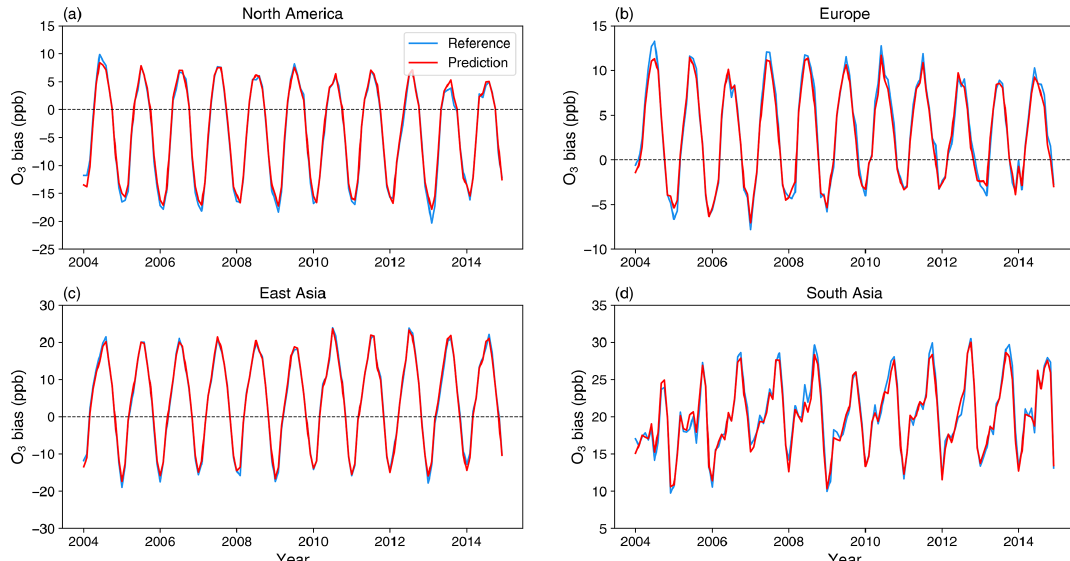
Figure 4. Monthly mean surface O 3 biases (UKESM1 minus CAMS; Reference) and O 3 biases predicted by the deep learning model in (a) North America, (b) Europe, (c) East Asia and (d) South Asia from January 2004 to December